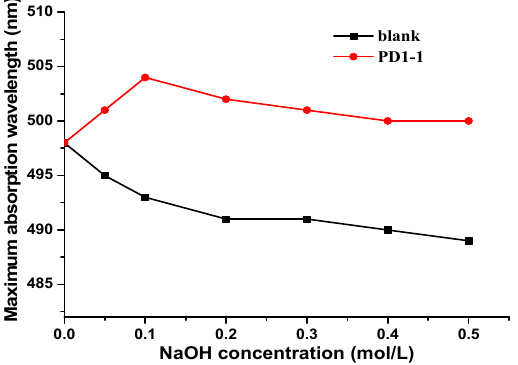
Figure 4. Maximum absorption plots of PD1-1 Congo red complex at various NaOH concentrations.